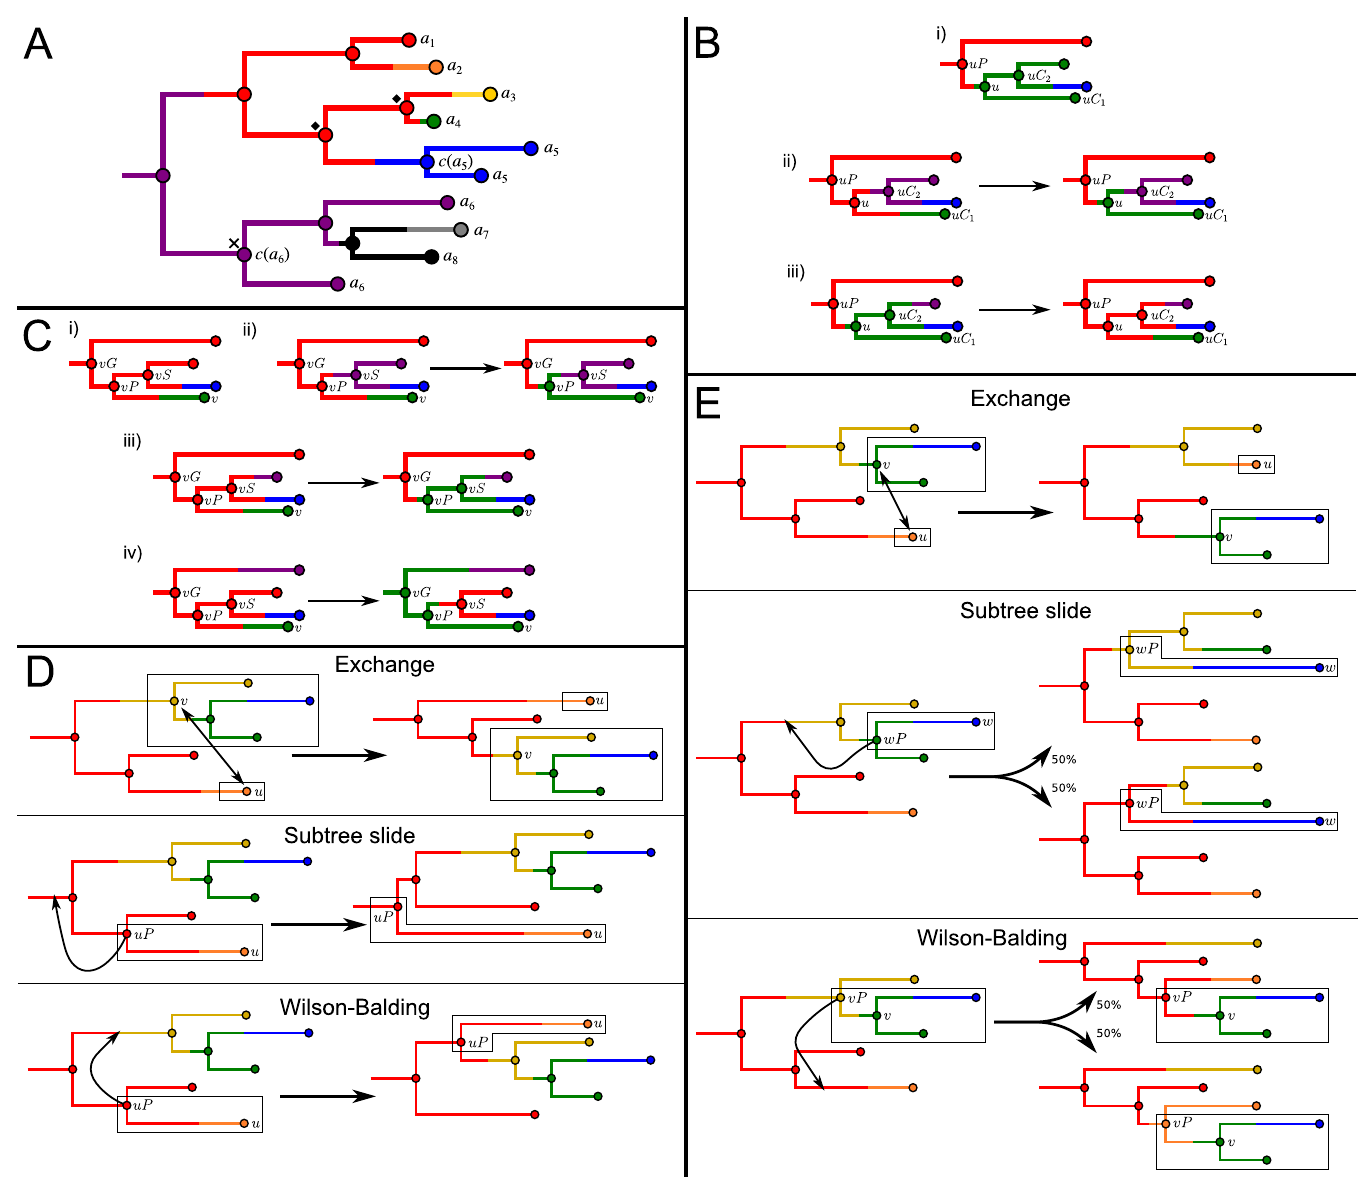
Fig 2. Illustrations of partitioned phylogenies and MCMC proposals modifying them. Nodes in all cases are coloured by the partition element containing them. (A) An example partitioned phylogeny. Tips are labelled by the hosts that the isolates corresponding to them were taken from. Where more than one isolate is taken from a host a i , c ( a i ) is labelled; in all other cases c ( a i ) is the single tip corresponding to an isolate taken from that host. Black diamonds designate nodes that are not ancestral under the partition. The hosts a 7 and a 8 are root-blocked by a 6 due to the position of c ( a 6 ) (black cross). (B) The downward infection branch move. The move attempts to move the node u from the green partition element to the red (which already contains its parent uP ). In i), the move is impossible because u is the MRCA node of the tips in the green element. In ii), it can be done with no further modifications required to obey the rules. In iii), the node uC 2 , which is not ancestral under the initial partition, must also be moved to the red element so the result obeys the rules. (C) The upward infection branch move. The move attempts to move the node vP from the red partition element to the green (which already contains its child v ). In i), the move is impossible because vP is ancestral under the partition and the host represented by the green element is root-blocked by the host represented by the red. In ii), it can be done with no further modifications required to obey the rules. In iii), the node vS , which is not ancestral under the initial partition, must also be moved to the green element, and in iv) the node vG must be because vS is ancestral. (D) The type A phylogeny moves. The exchange move exchanges the nodes u and v ; the subtree slide and Wilson-Balding moves change the position of the node u and its parent uP . (E) The type B phylogeny moves. The exchange move exchanges the nodes u and v ; the subtree slide move the node w and its parent wP , and the Wilson-Balding the node v and its parent vP . After the latter two moves the transplanted parent node is randomly assigned to one of two new partition elements with equal probability.